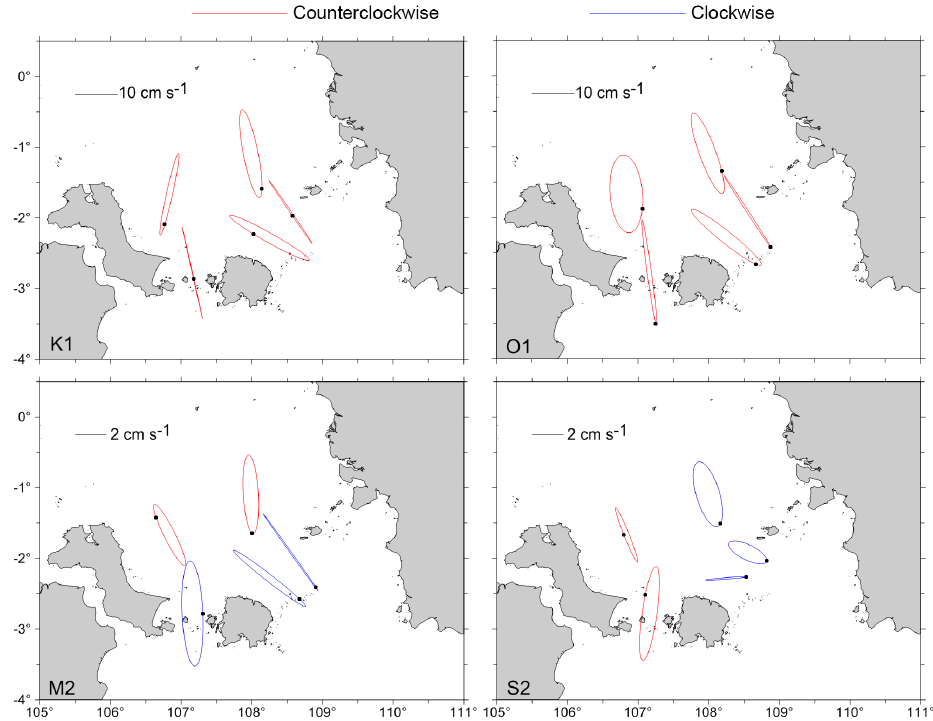
Figure 3. The vertically averaged tidal current ellipses of principle tidal constituents K 1 , O 1 , M 2 , and S 2 at the observational stations. Dots on the ellipses represent the tips of the tidal current vectors at